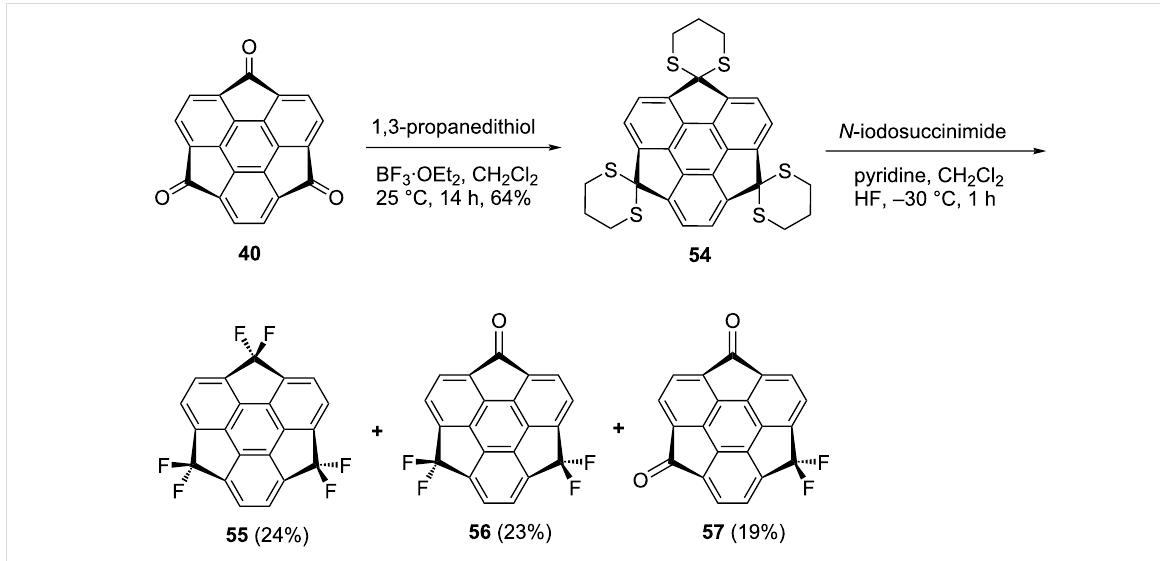
Scheme 12: Synthesis of hexafluorosumanene derivative 55 by Sakurai and